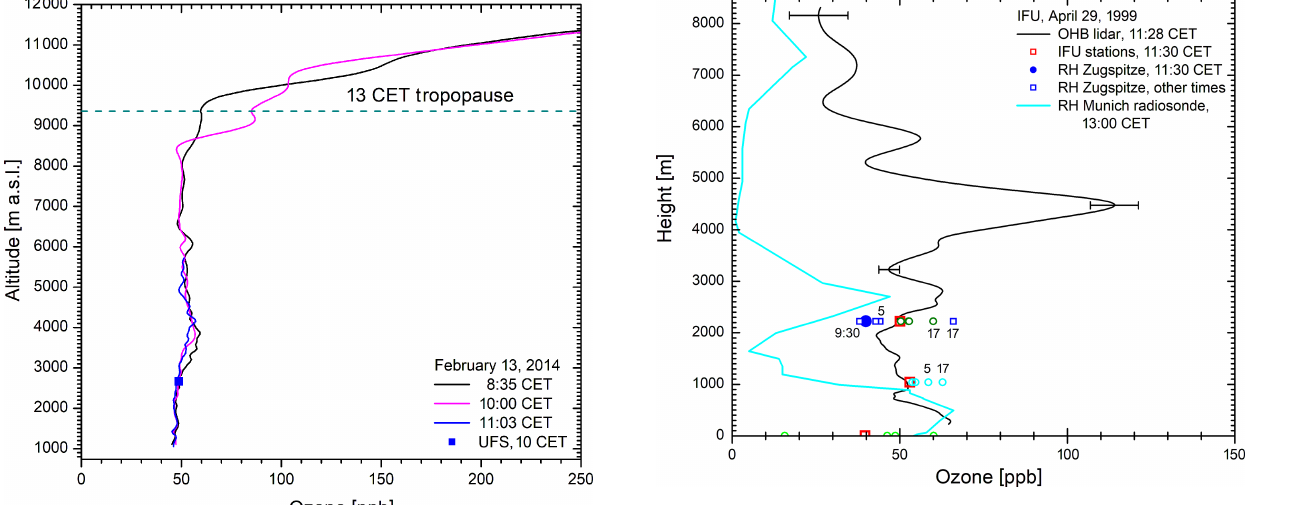
Figure 19. Ozone measurement with the mobile DIAL during the brightest part of the day, after all modifications had been made (about 10 4 laser shots); the vertical axis is the height above the lidar site (IFU, 730ma.s.l.), and up to 2.7km above the ground 266–299nm wavelength pairs were taken (near-field: up to 1.5km). Up to 3.7km the combination 289–299nm was used. Above this, ozone was obtained from a single-trace eval- uation for 299nm, slightly recalibrated at the lower end of that range. For comparison, in situ ozone values from the three local monitoring stations IFU (745ma.s.l.), Wank (1780ma.s.l.), and Zugspitze (2962ma.s.l.) are shown for 11:30CET (red squares). Additional values from these stations are marked with open circles for 05:00CET, 09:30CET, 14:00CET, and 17:00CET (labelled in some cases). For the interpretation of the complicated meteorolog- ical situation, the corresponding relative humidity of the Zugspitze summit and the noon operational ascent of the Munich radiosonde are also included. Outside the most reliable part of the operating range a few representative error bars are